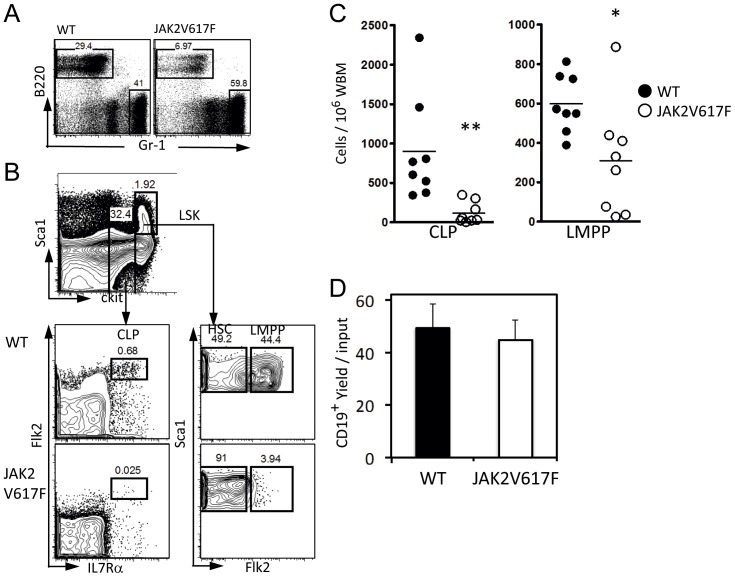
Lymphoid progenitors are depleted in JAK2V617F transgenic mice.(A) Whole bone marrow cells were characterized by staining with B220 (lymphoid specific) and Gr1 (myeloid specific) antibodies. (B) The c-kitL°CLP fraction was defined by staining for Flk2 and IL-7Rα (left panels). The LSK fraction was divided for enumeration of Flk2Hi LMPP. (C) Percentages of CLP (left panel) and LMPP (right panel) are shown. The data are representative of those obtained in three independent experiments (N = 8). (D) Lymphoid potential is similar between WT and JAK2V617F CLP. CLP were cultured in serum- and stromal cell-free culture for 7 days. Production of differentiated CD19+ cells were calculated as yields per input progenitor. The data are representative of those obtained in two independent experiments p<0.01(**), p<0.05(*).